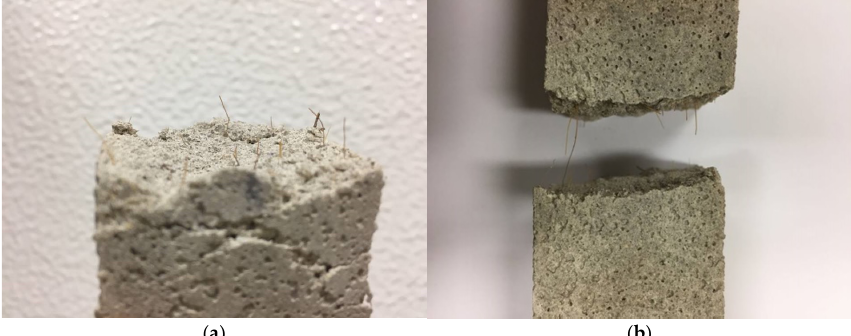
Figure 10. Coir fiber-reinforced cement-based mortars specimens after ( a ) compressive strength test and ( b ) flexural strength test.